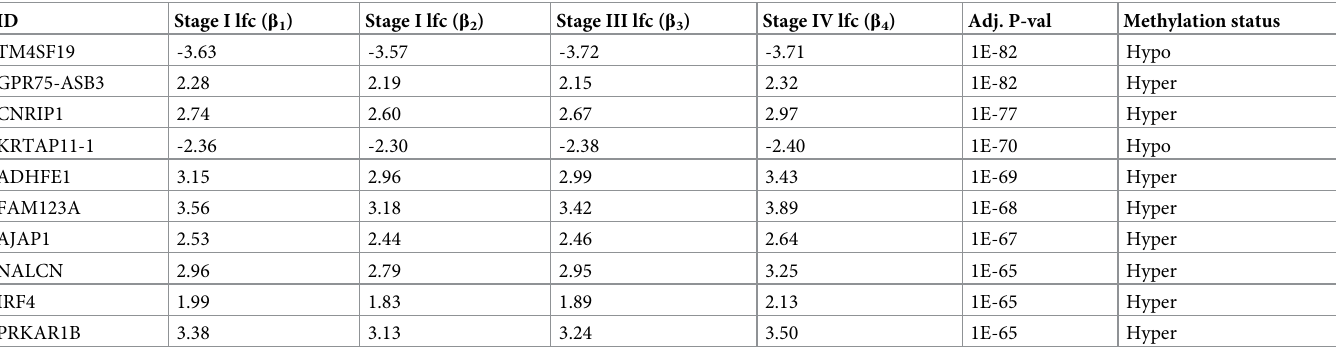
Table 3. Top ten genes of linear modelling with averaging of multiple probes.